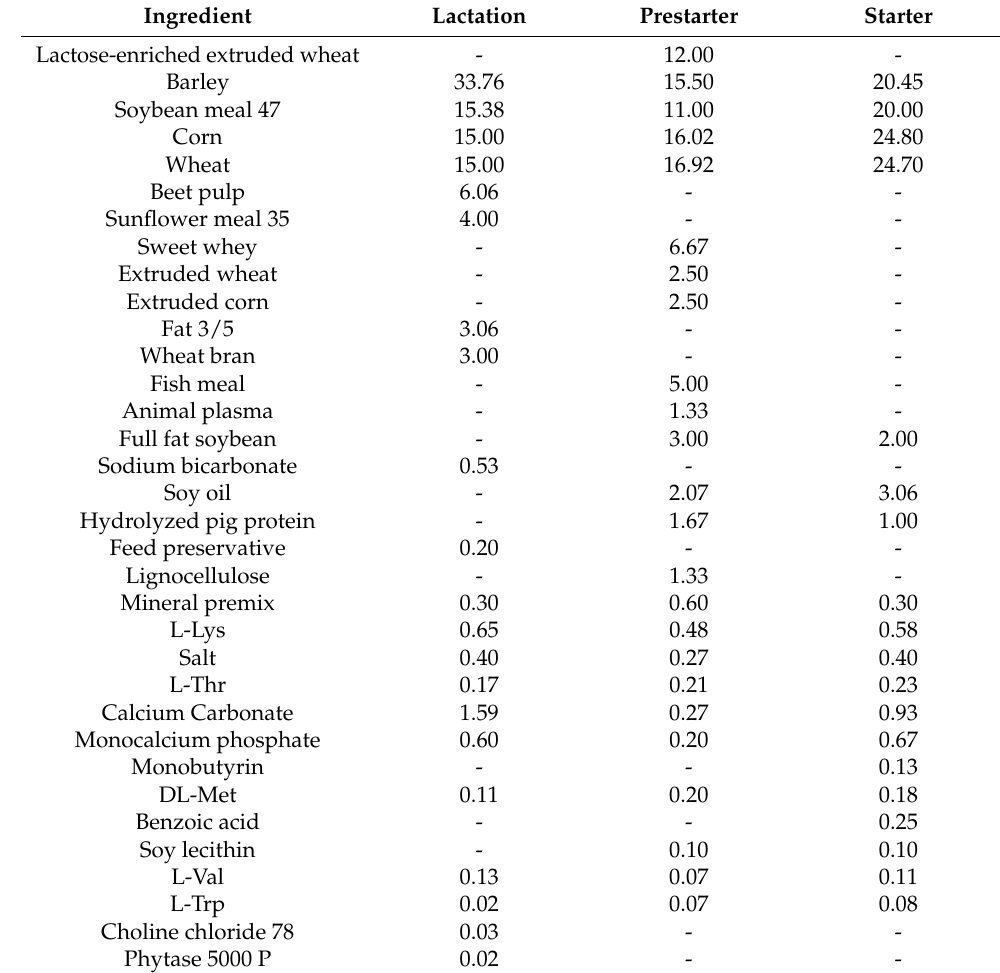
Table 1. Composition of the control experimental diets (%, as fed). Ingredient Lactation Lactose-enriched extruded